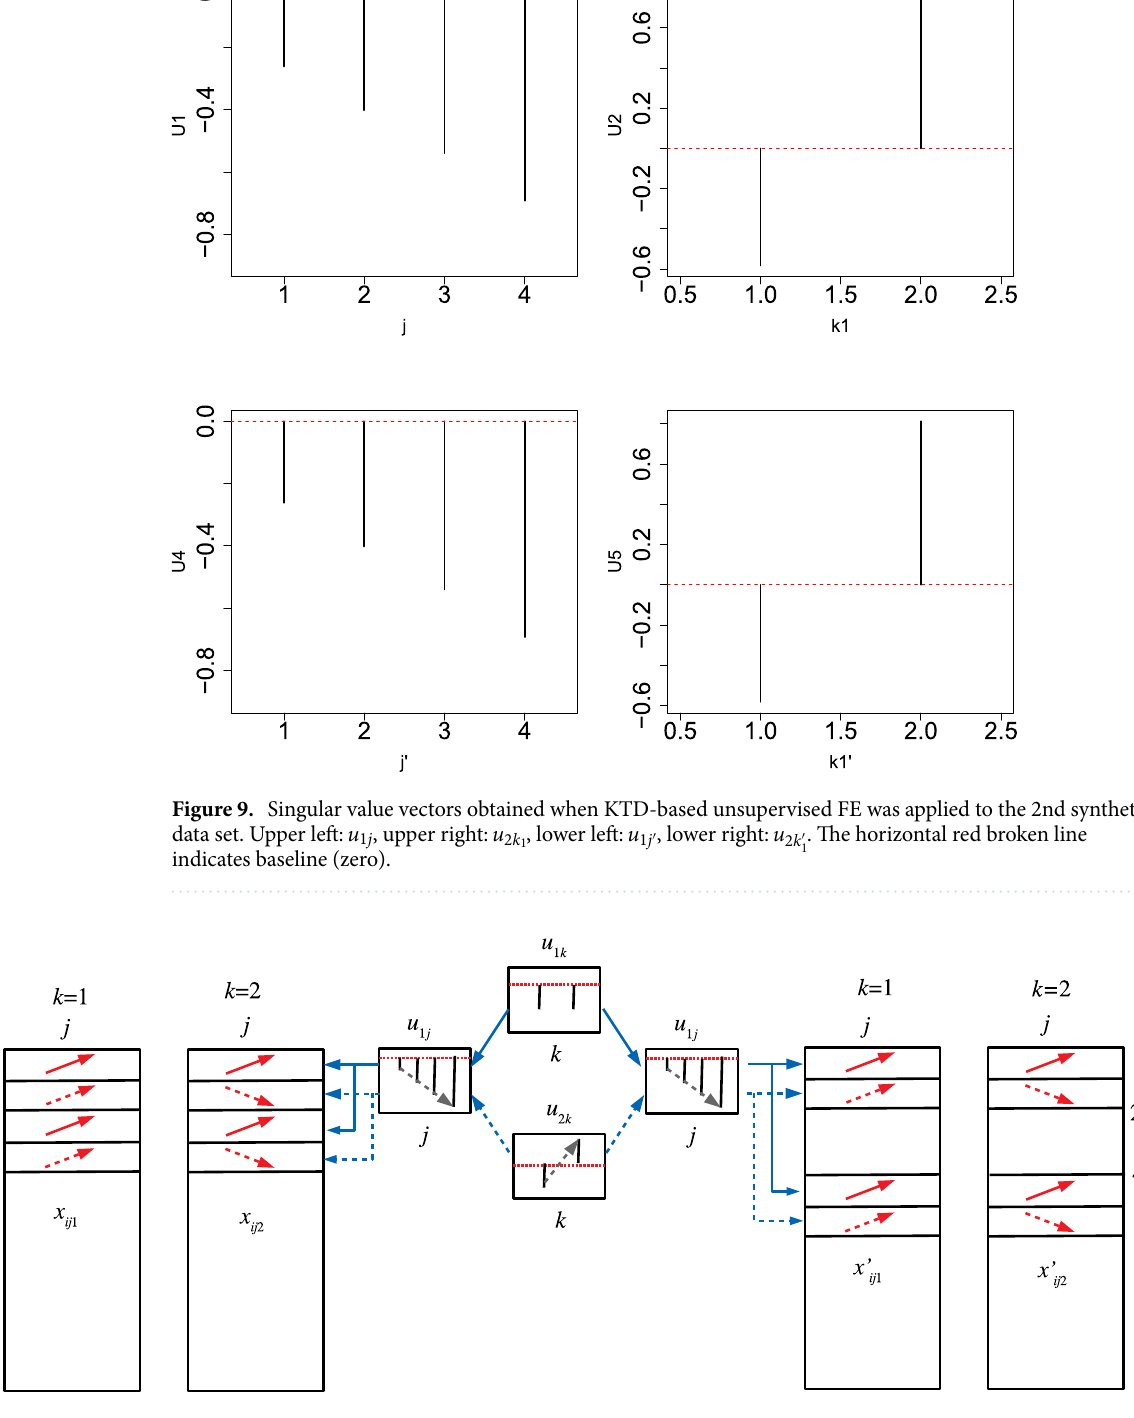
Figure 10. Schematic figure that explains the correspondence between x ijk , i ≤ N 1 , 2 N 1 < i ≤ 3 N 1 , , i ≤ N 1 , and 4 N 1 < i ≤ 5 N 1 (red solid arrows) and u 1 x ′ ijk